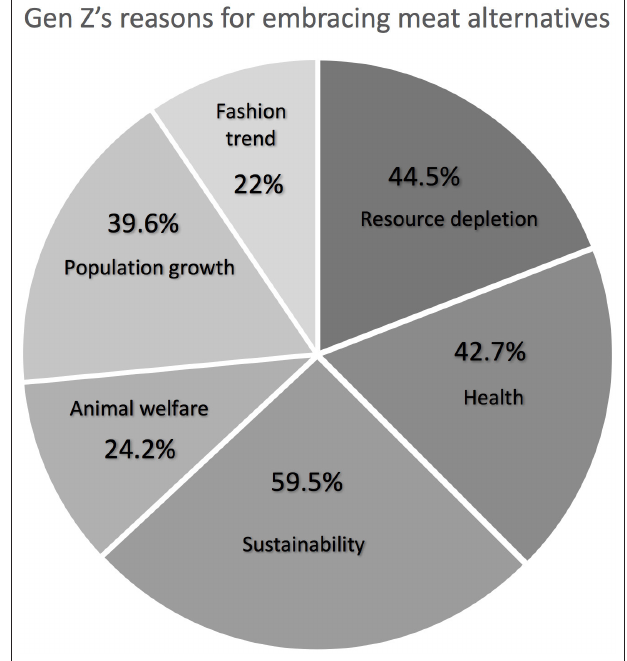
FIGURE 3 | Reasons for embracing meat alternatives by Sydney Gen